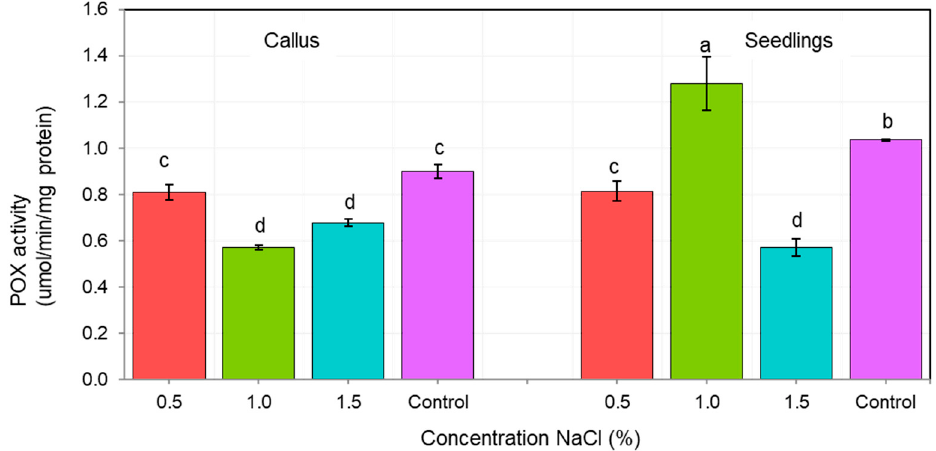
Figure 5. Changes in nonspecific peroxidase (POX) activity in of F. excelsior callus and seedlings. Other letters—there are statistically significant differences.